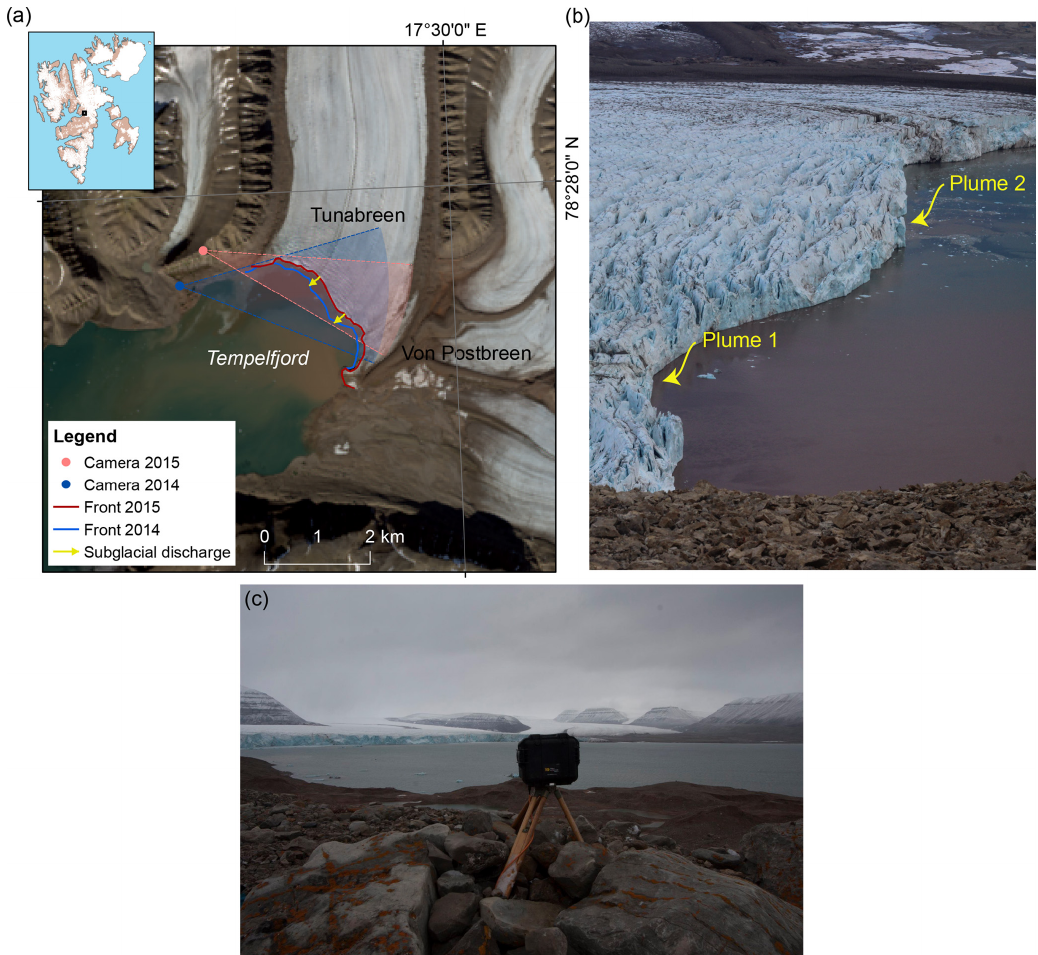
Figure 1. (a) Map of Tunabreen, Svalbard, with subglacial discharge positions, time-lapse camera positions and angles of vision. Front position as of September 2014 and August 2015. The satellite image is a Landsat 8 OLI–TIRS C1 Level 1 (14 August 2015). (b) Picture taken on 8 August at 15:00 showing the two plumes of Tunabreen. (c) Time-lapse camera used for 2014 analysis standing in front of